Question: Sum up the contents of this chart in one sentence.
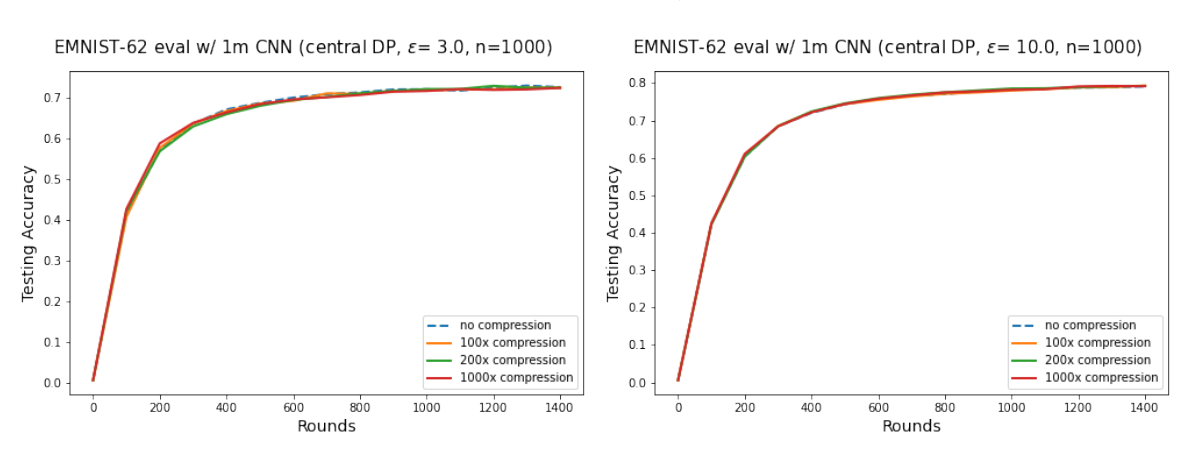
Answer: Accuracy of GM and CSGM, with δ = 10−5 and cohort size 1000. The ∆∞/∆2 ratio is 6.4 · 10−3